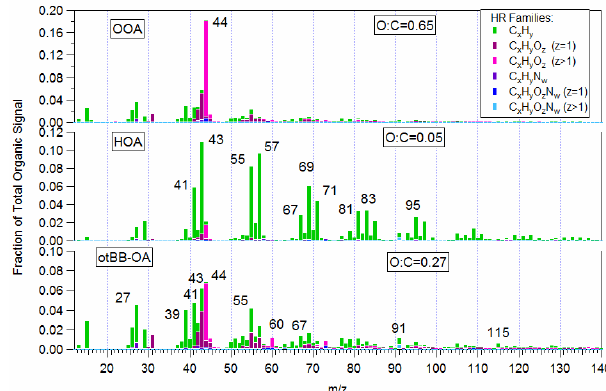
Fig. 9. Mass spectra of OA components from the PMF 3-factor so- Figure 9. Mass spectra of OA components from the PMF 3-factor solution. lution.